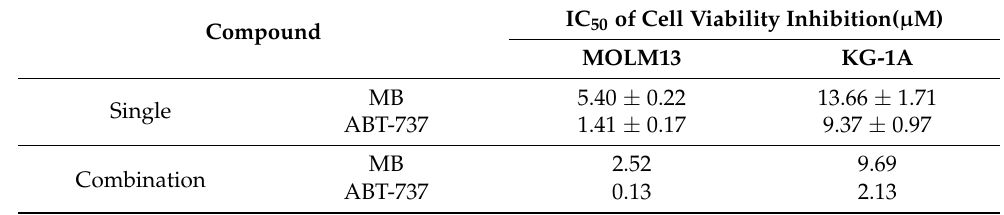
Table 4. Synergistic inhibitory effects of MB and ABT-737 on AML cells.